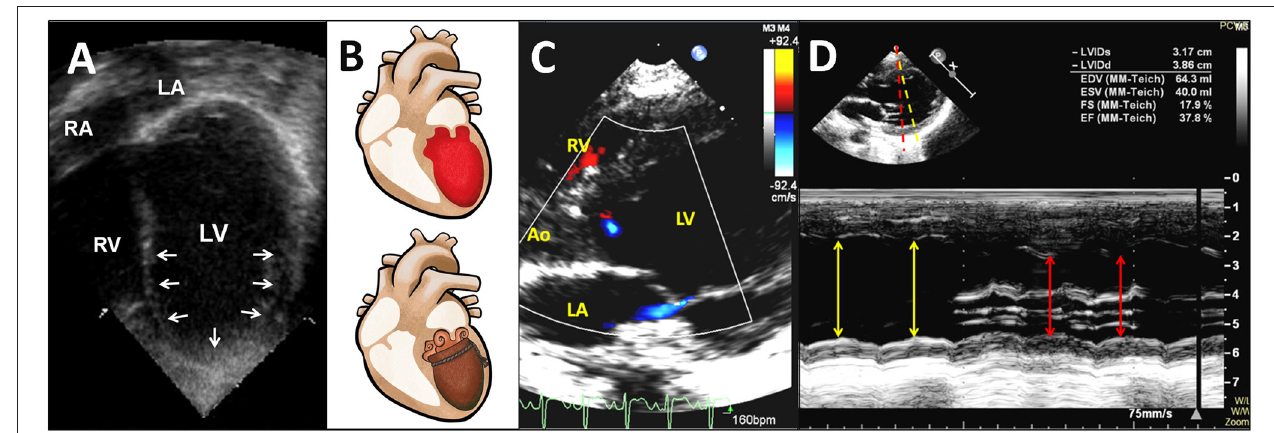
FIGURE 2 | Transthoracic two-dimensional echocardiogram in the apical four-chamber view shows a mid-ventricular pattern of a circumferential regional wall motion abnormality with conspicuous apical ballooning of the LV in a 20-month-old patient in the year 2000 (A) (also see Supplementary Video 1 ). Diagram demonstrates the apical ballooning shape of the LV with an appearance resembling an octopus pot (called Tako-tsubo) (B) . Transthoracic color Doppler echocardiogram in the parasternal long-axis view shows LV dysfunction with a circumferential regional wall motion abnormality resulting in apical ballooning of the LV during systole, and mild mitral regurgitation in a 3-year-old patient in the year 2018 (C) (also see Supplementary Video 2 ). An M-mode echocardiographic recording from the level of the mitral valve chordae to the level of the mitral valve reveals a circumferential LV regional wall motion abnormality along yellow and red lines (D) . Ao, aorta; LA, left atrium; LV, left ventricle; RA, right atrium; RV, right